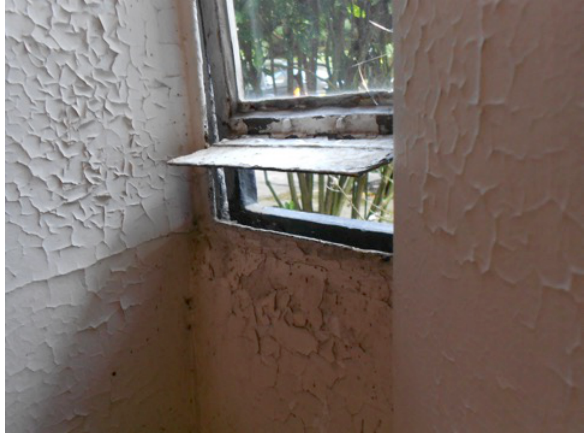
Figure 8. Internal surfaces and frames decay, current state [Di Resta,